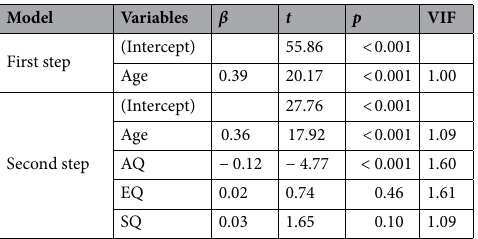
Table 3. Results for the multiple regression analysis for CSM in Survey 1.